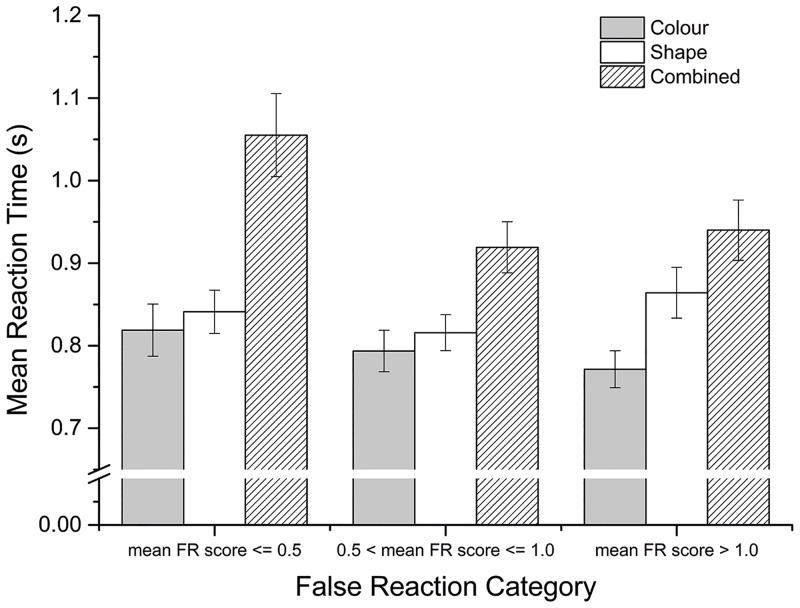
Bar graph depicting the significant interaction between condition and false reaction (FR) category for mean reaction time in Experiment 1.Error bars are 95% confidence intervals.